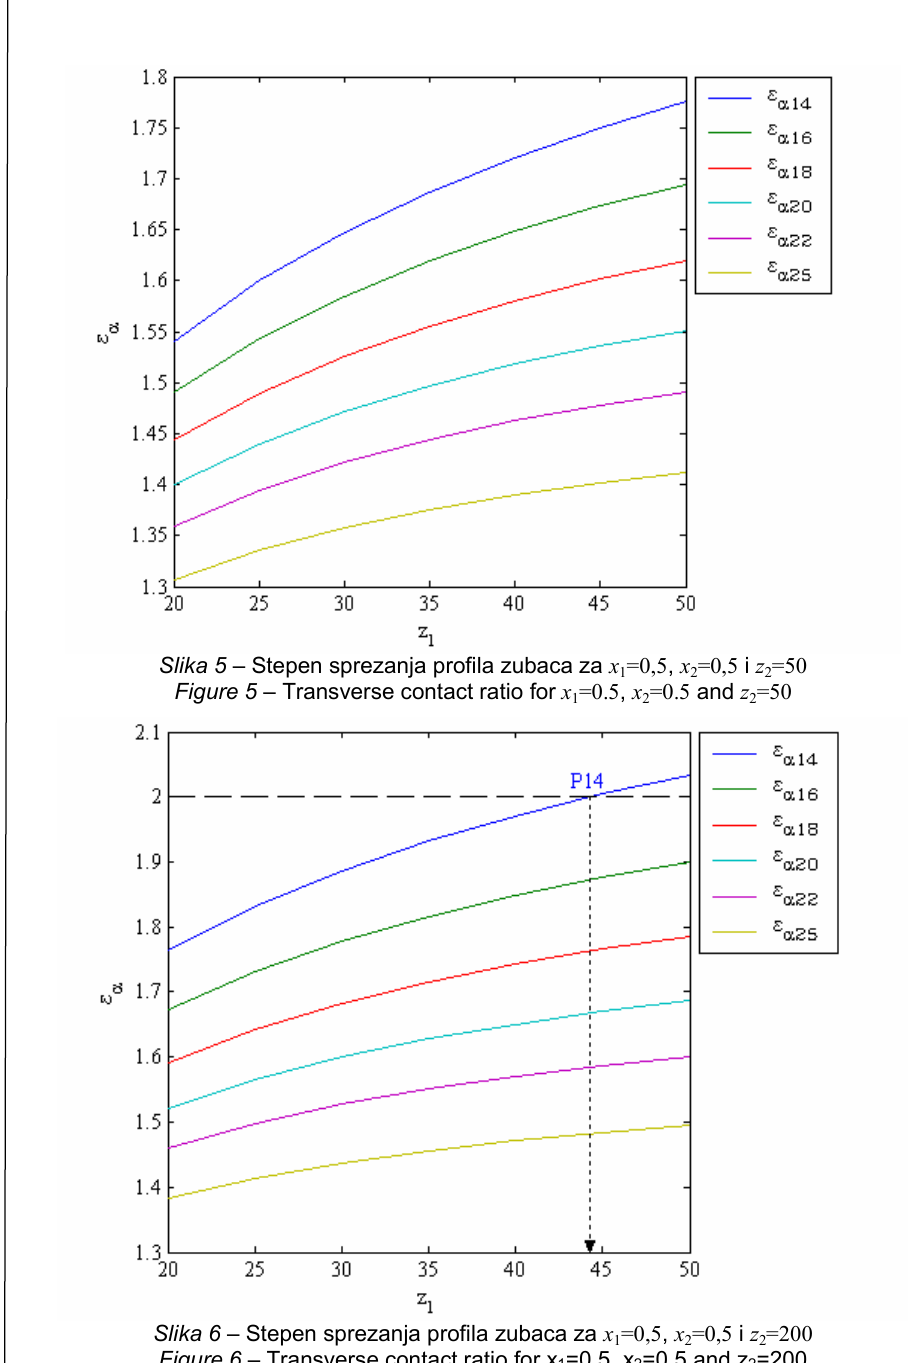
Figure 6 – Transverse contact ratio for x 1 =0.5, x 2 =0.5 and z 2